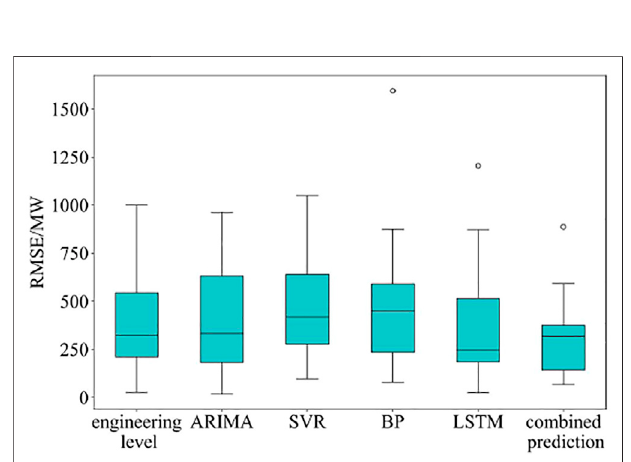
FIGURE 10 | RMSE box diagram of each model.